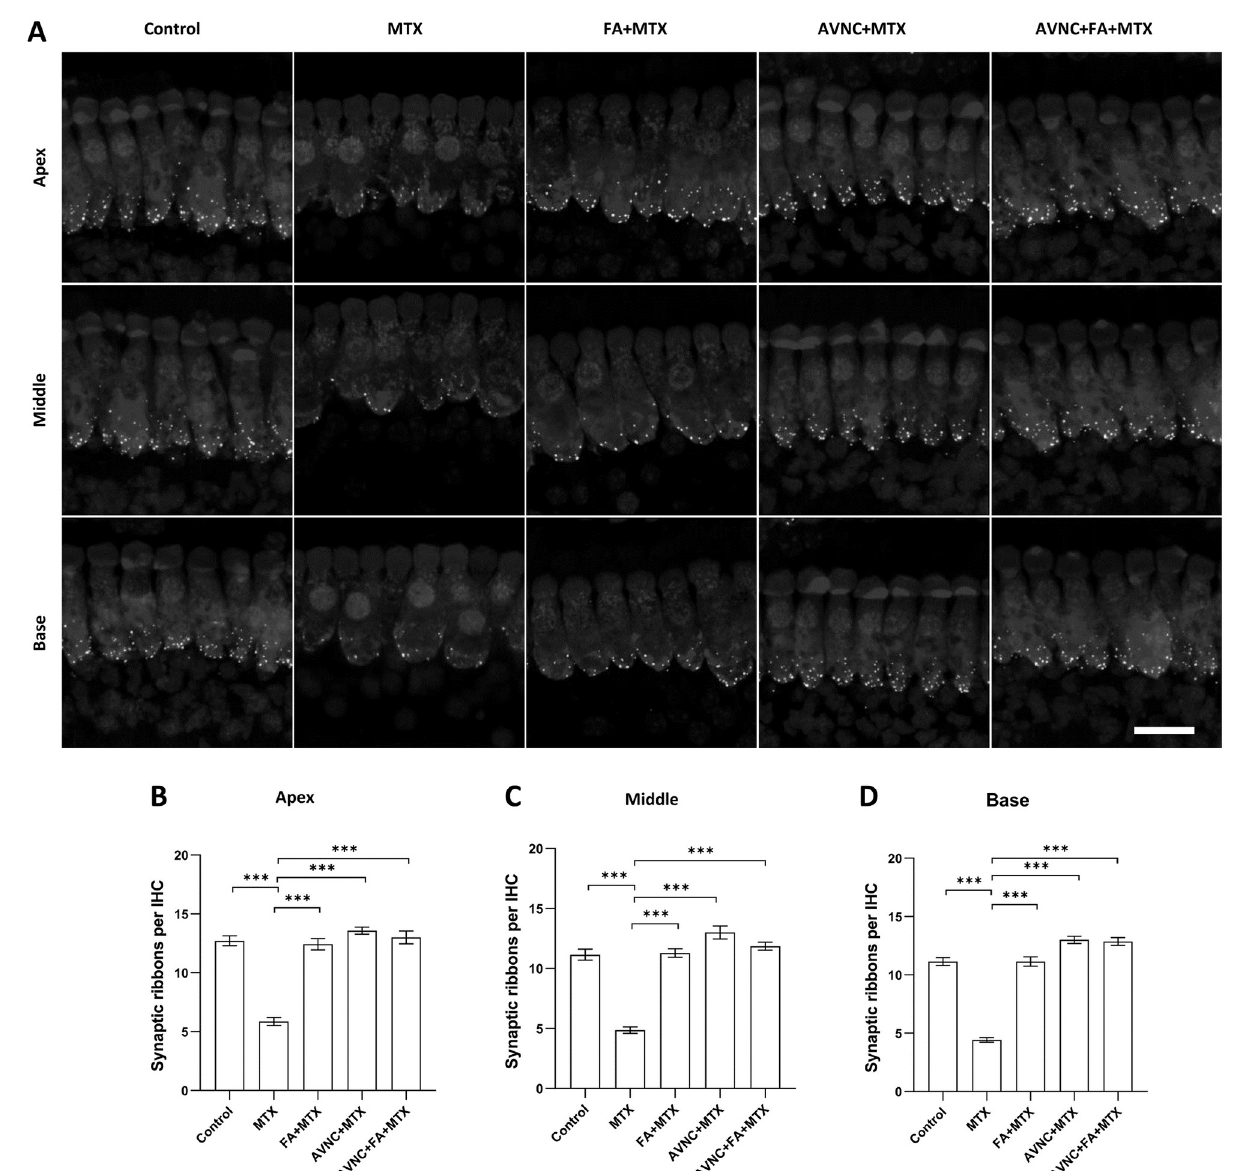
Fig 4. AVN-C blocks synaptic ribbon damage caused by MTX treatment. A. The number of CtBP2 positive signal (synaptic ribbons) in the MTX- treated group was significantly decreased in all three turns of the cochlea. B, C, and D. In the MTX-treated group, the number of synaptic ribbons in the base (4 ± 0.7), middle (5 ± 0.7), and apex turns (6 ± 0.9) were reduced. The AVN-C-treated group recorded a high number of synaptic ribbons at the base (13 ± 0.8), middle (13 ± 1.4), and apex turns (14 ± 0.8). The FA+MTX-treated (11 ± 1.1; 11 ± 1, and 12 ± 1.3, respectively), AVN-C+FA+MTX-treated (13 ± 1.3, 12 ± 0.9, and 13 ± 1.4, respectively), and control groups (13 ± 1.1, 11 ± 1.2, and 11 ± 0.9, respectively) maintained a significant number of synaptic ribbons in the base, mid, and apex turns. ��� p < 0.001. The Fig 4A is presented in black and white to clearly distinguish the distribution of cochlear synapses in IHCs of the cochlea. The white dots represent synaptic ribbons stained with CtBP2, whereas the inner hair cells were stained with myosin-7a. n = 7, and scale bar: 20 μ m.